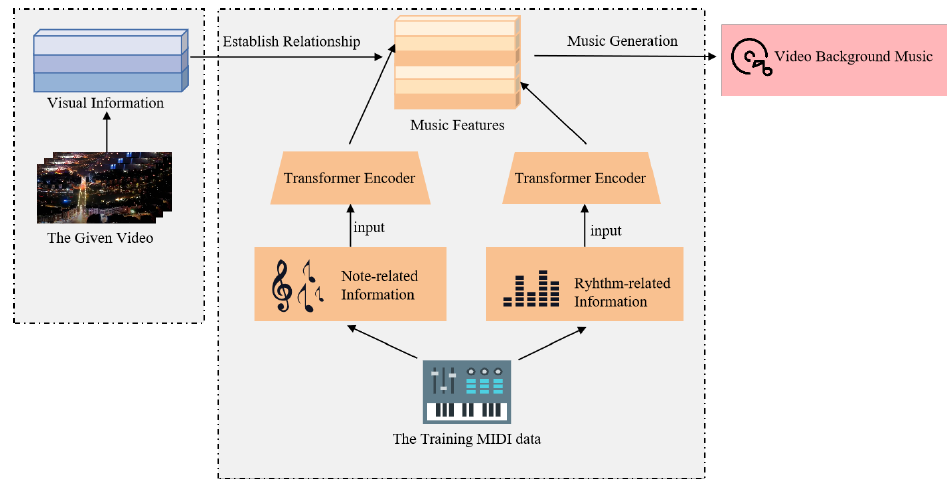
Figure 2. The overall architecture of the proposed video background music generation